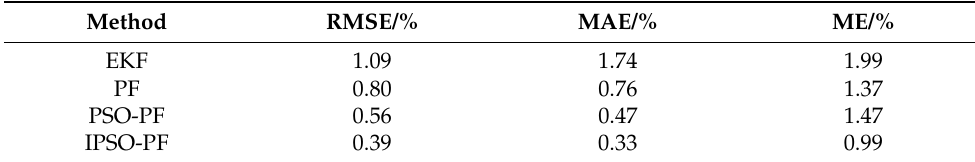
Table 4. Errors of DST Driving Condition.